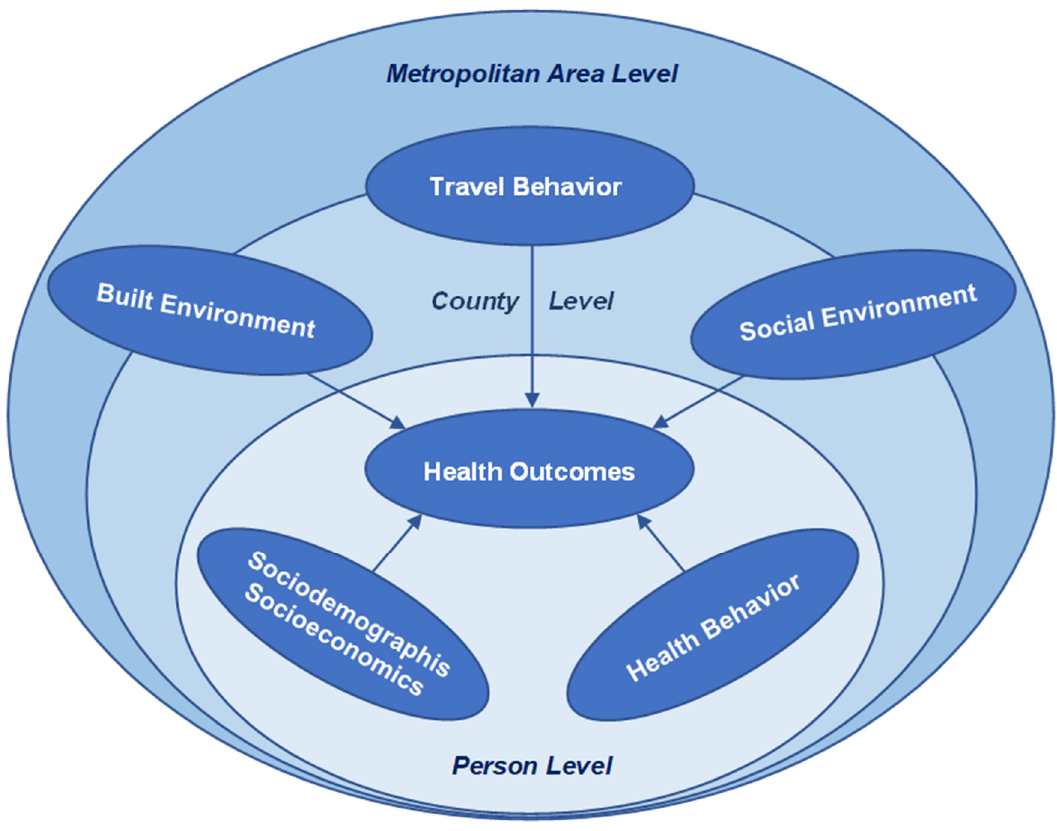
Figure 3. The proposed ecological model framework for the present study.